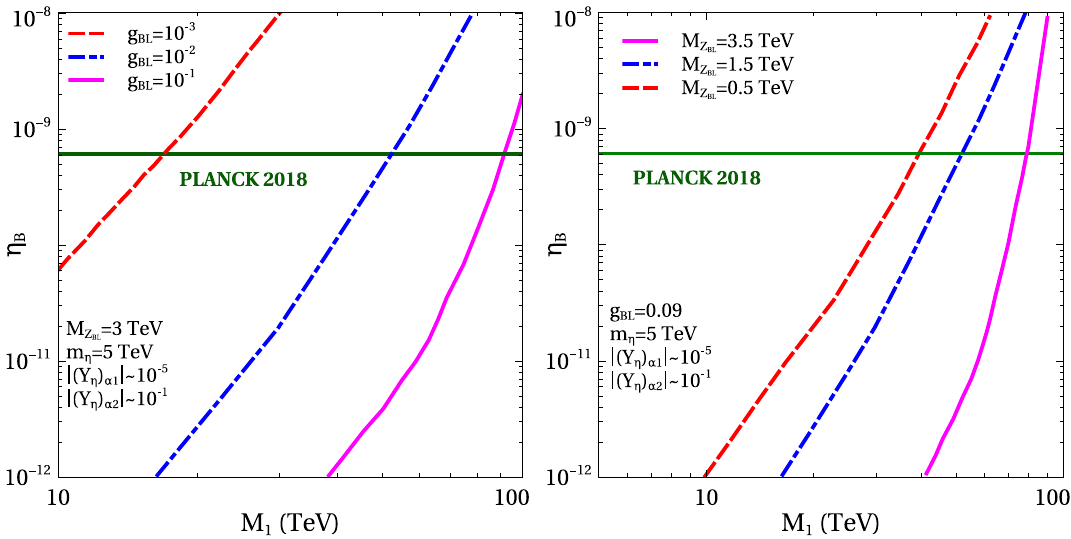
Fig. 6 Baryon to photon ration with mass of N 1 for different benchmark values of g BL (left panel) and M Z are ( Y η ) α 1 = 10 − 5 ( 1 + i ) and ( Y η ) α 2 = 3 × 10 − 1 ( 1 . 1 − i